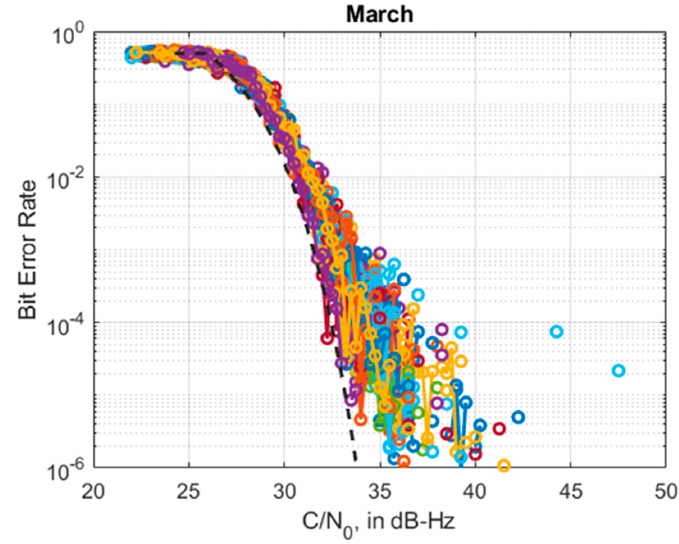
Figure 7. Daily BER versus C / N 0 for the month of March 2021. The dashed black line represents the theoretical BER curve assuming Gaussian noise. Different colors refer to different days of the month. Moreover, the daily PER was evaluated and is shown in Figure 8 for the entire period under observation. The estimated daily PER is always below one percent. It should be